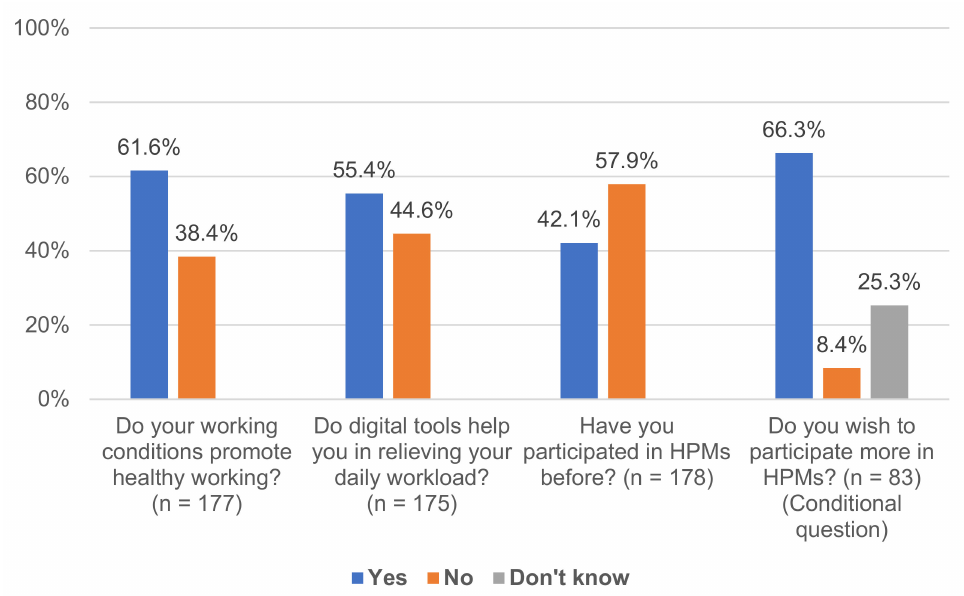
Figure 1. Frequencies of Managers’ Perceived Working Conditions and HPM Participation.